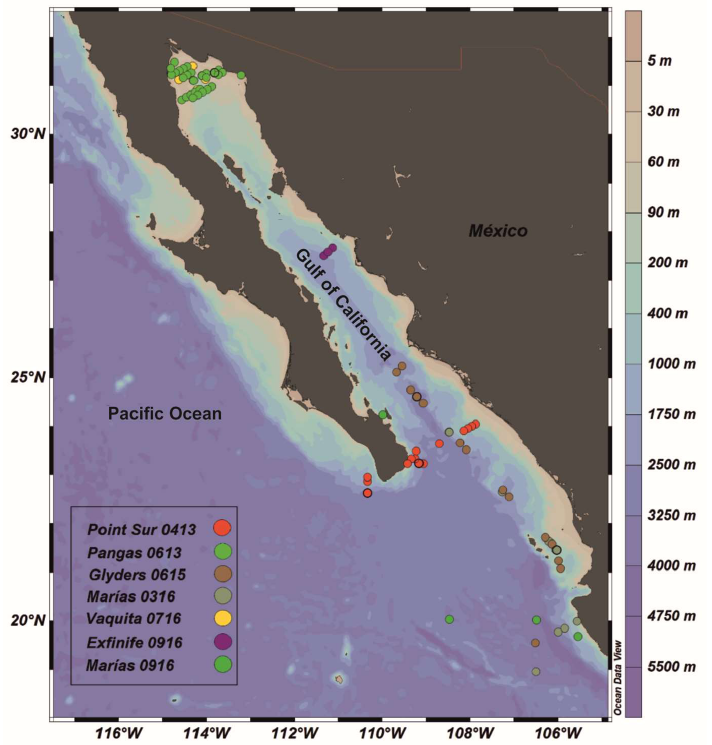
Figure 1. Map showing the locations of the stations used in this study. Table 1. Number of stations from which data for each variable were obtained. Cruise Images Z SD Point sur 0413 Pangas 0613